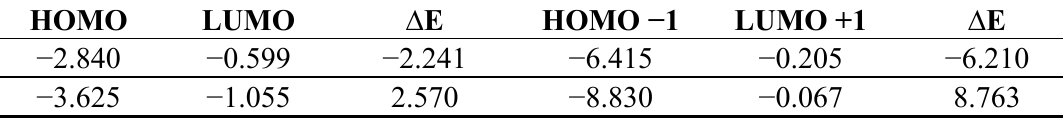
Table 1. HOMO and LUMO energies of 5 and 7 ( eV